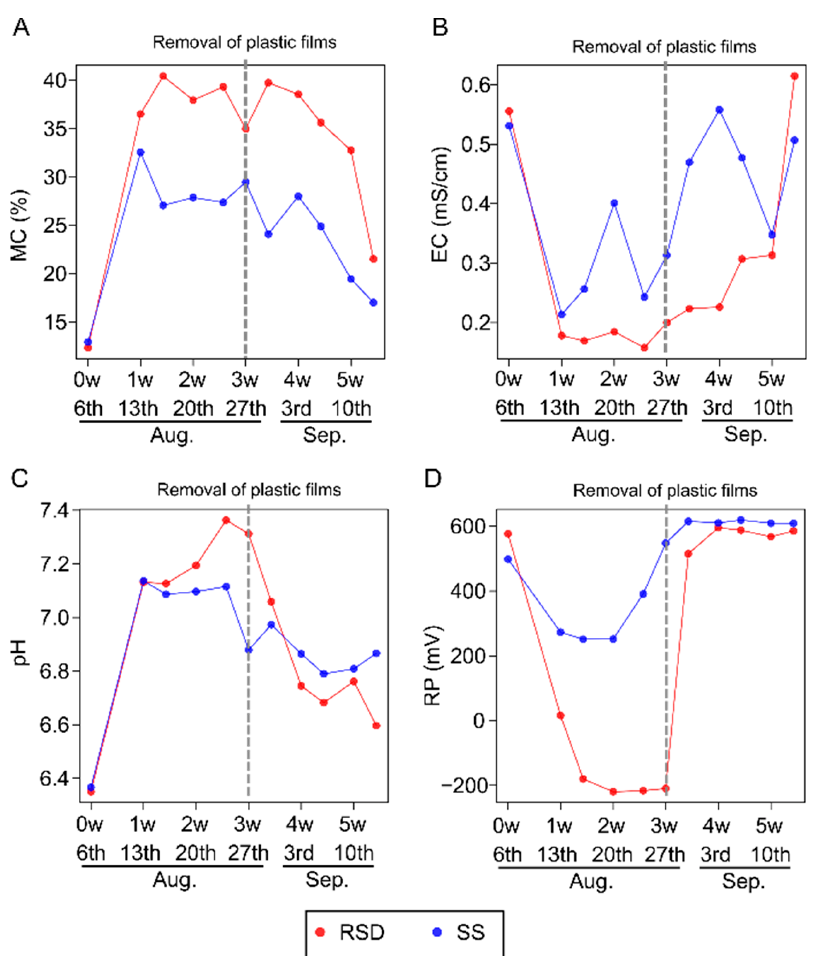
Figure 1. Fluctuation of environmental parameters in soil under reductive soil disinfestation (RSD) and soil solarization (SS). Values are the average of: ( A ) moisture content (MC) ( n = 3), ( B ) electric conductivity (EC) ( n = 3), and ( C ) pH ( n = 3), and ( D ) the daily average of redox potential (RP) measured every hour on 6, 13, 16, 20, 24, 27, and 30 August and 3, 6, 10, and 13 September 2019. Red denotes RSD, whereas blue denotes SS.